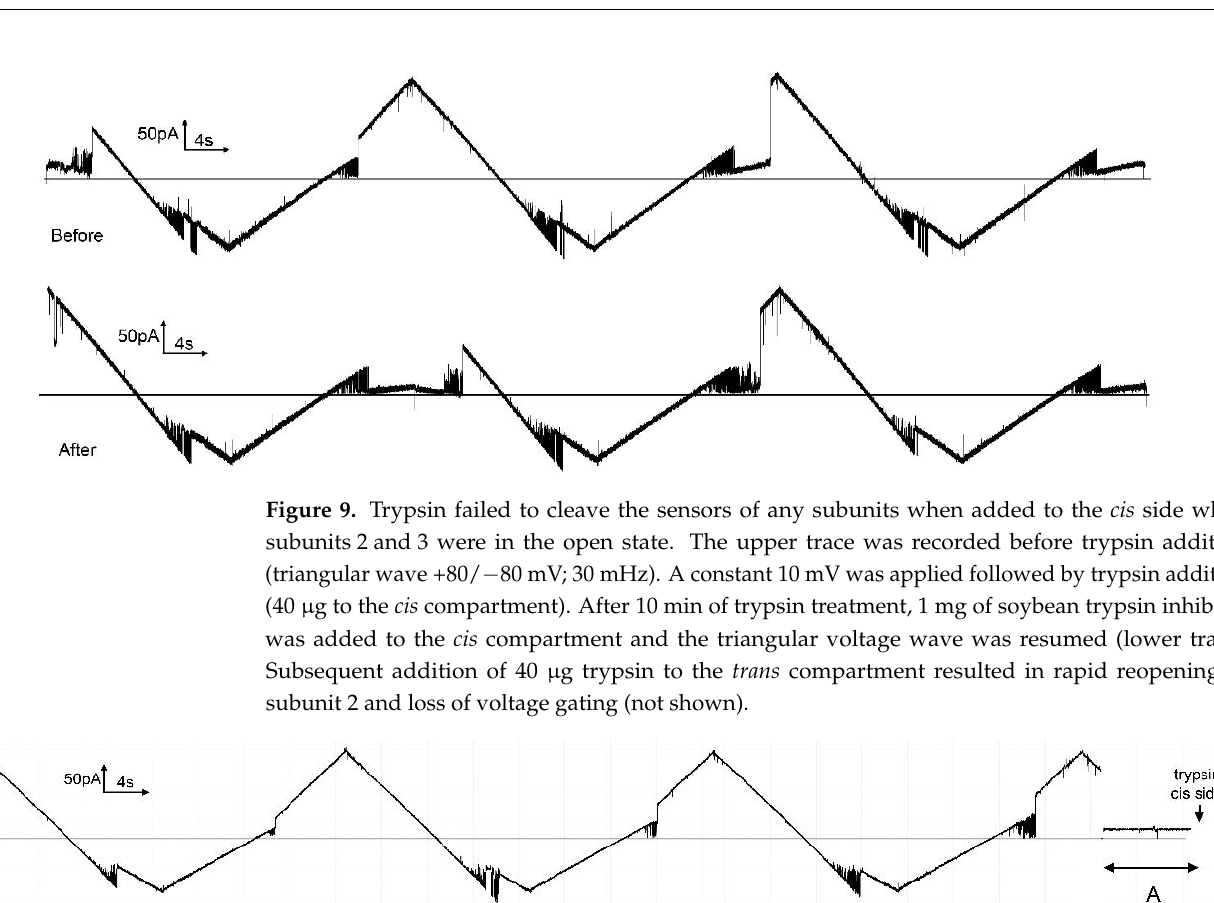
Figure 8. Trypsin added to the trans compartment cleaved the sensor of subunit 2. The upper trace was recorded before trypsin addition (triangular wave +81/ −7 9 mV; 30 mHz). A constant 10 mV was applied followed by trypsin addition (60 ug to the trans compartment). After 10 min of trypsin treat- ment, 1 mg of soybean trypsin inhibitor was added to the trans compartment and the triangular voltage wave was resumed (lower trace).